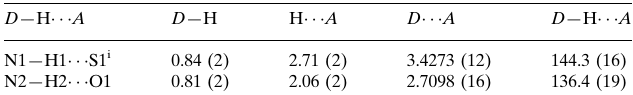
Hydrogen-bond geometry (A˚ , (cid:2)